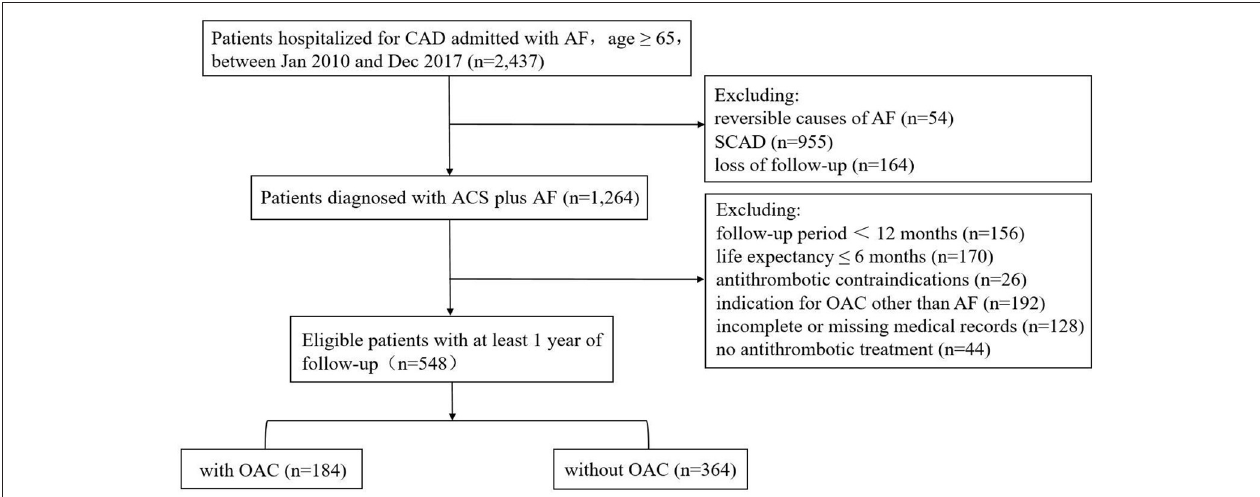
FIGURE 1 | Flow chart over selection of the cohort. CAD, coronary artery disease; AF, atrial fibrillation; SCAD, stable coronary artery disease; OAC, oral anticoagulant.